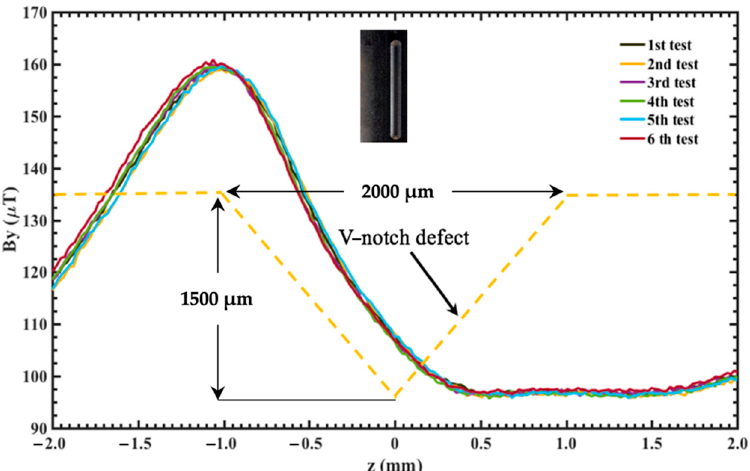
Figure 8. Variation of normal MMM signals measured around the third V-shaped notch (2000 µm width and 1500 µm depth) of the ASTM-A36 steel pipe, which were measured using six experimental tests.